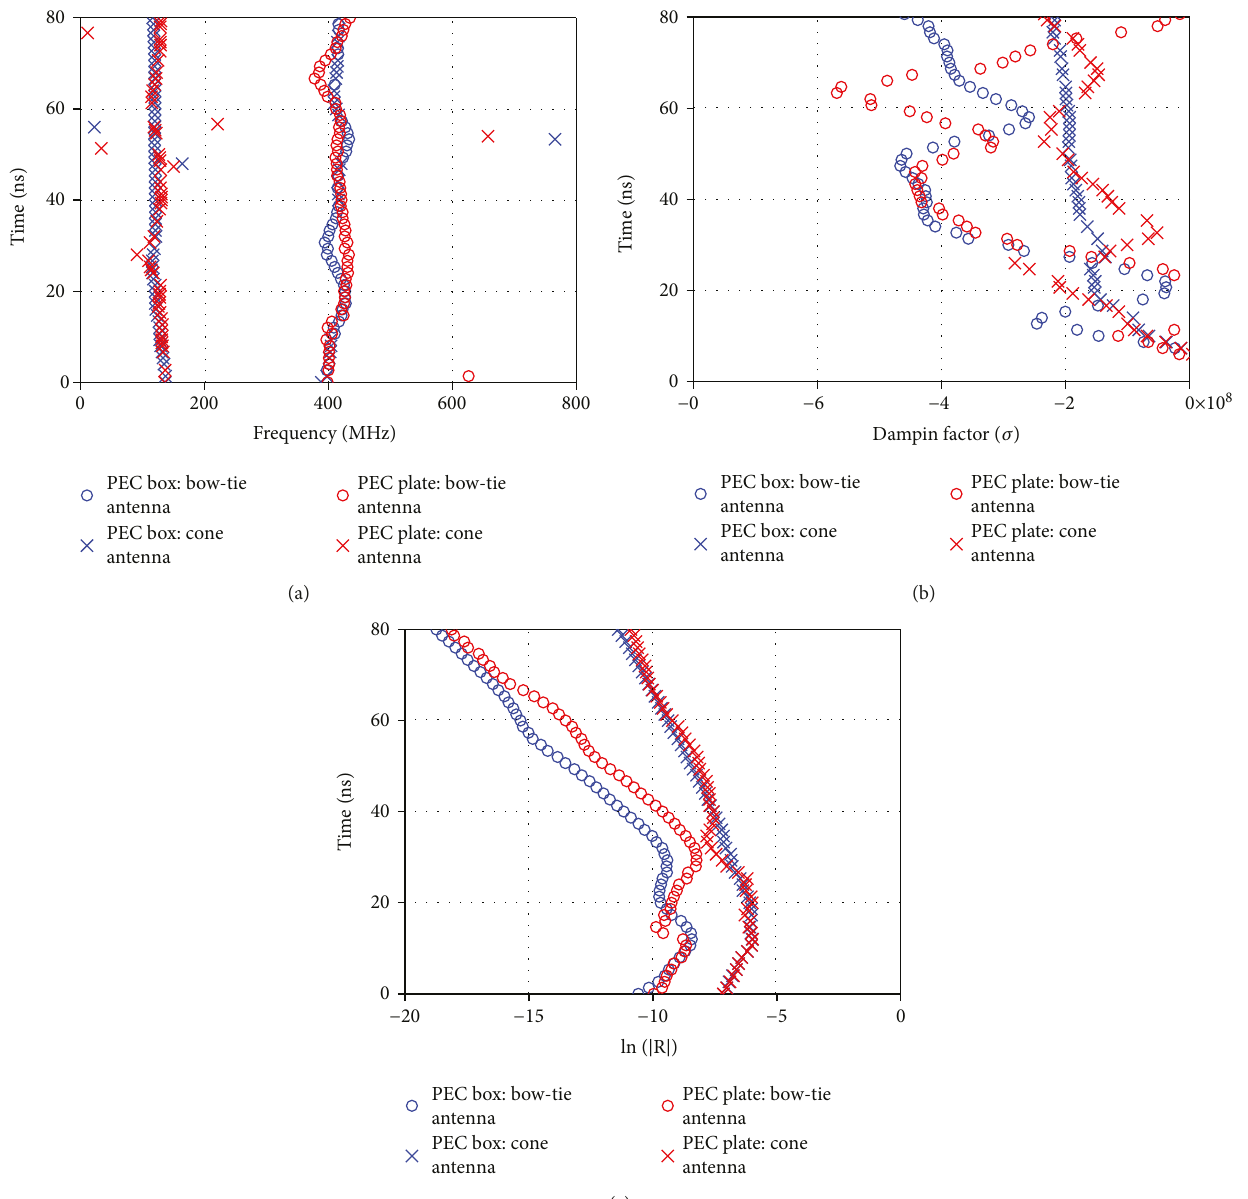
Figure 3: Extracted poles from simulations without fi ltering the antenna e ff ects; (a) imaginary part (b) real part, and (c) magnitude of